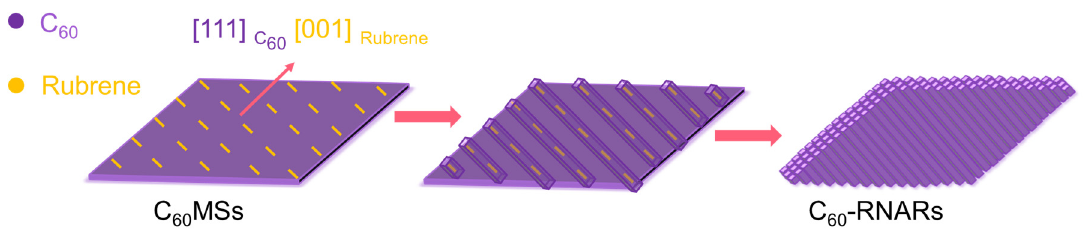
Figure 6. Schematic illustration of the transformation from C 60 MSs to C 60 -RNARs . Effects of the rubrene concentration in m -xylene on the formation of nanorod arrays